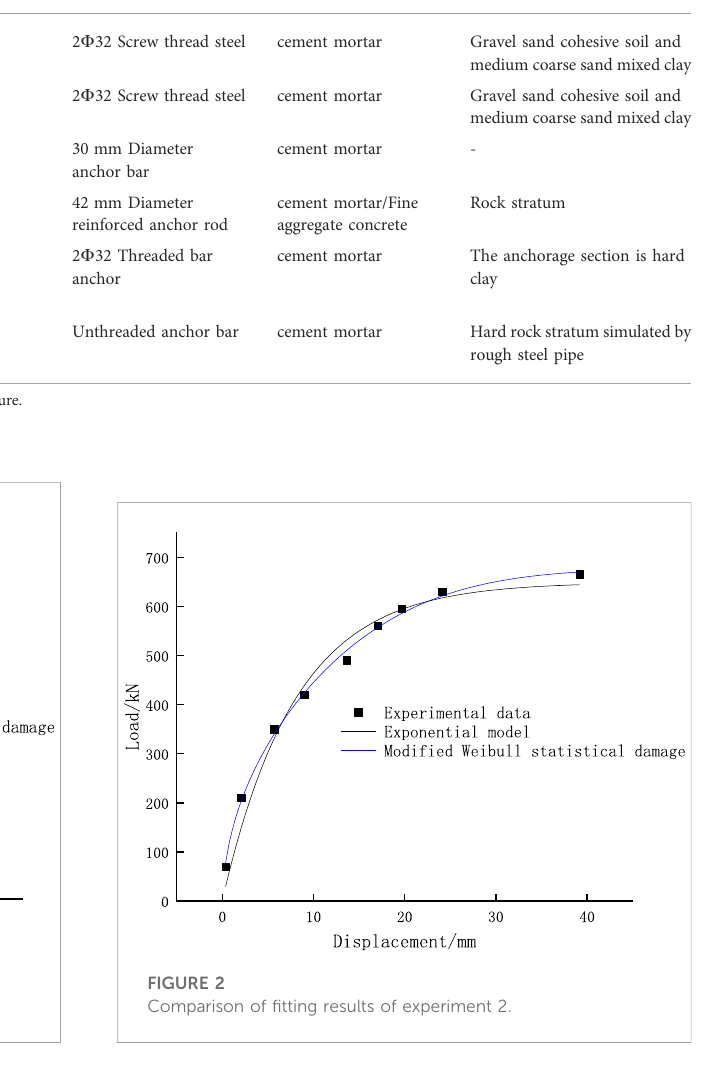
FIGURE 1 Comparison of fi tting results of experiment 1.